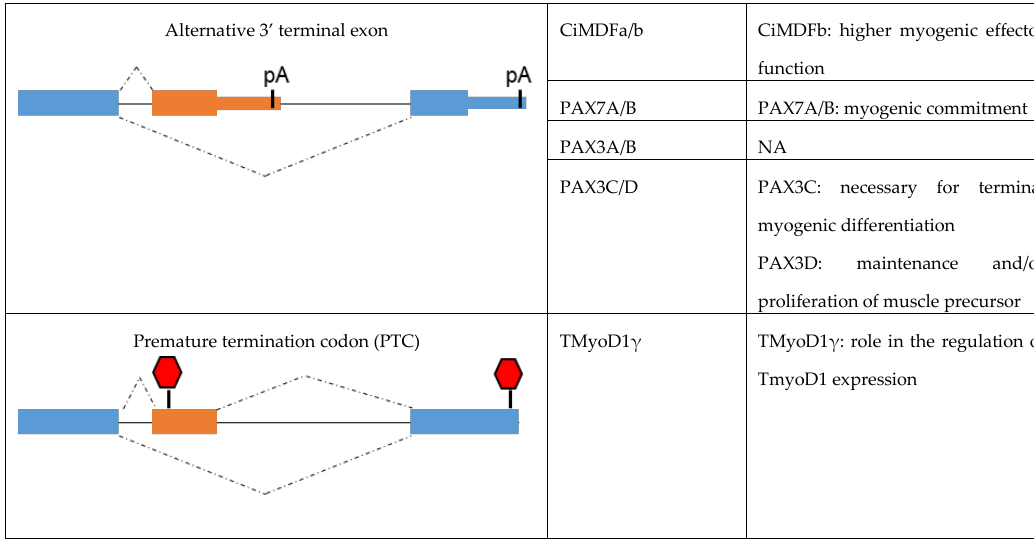
Figure 2. Type of alternative splicing events occurring in muscle-related transcription factors and impact on their functional activity.